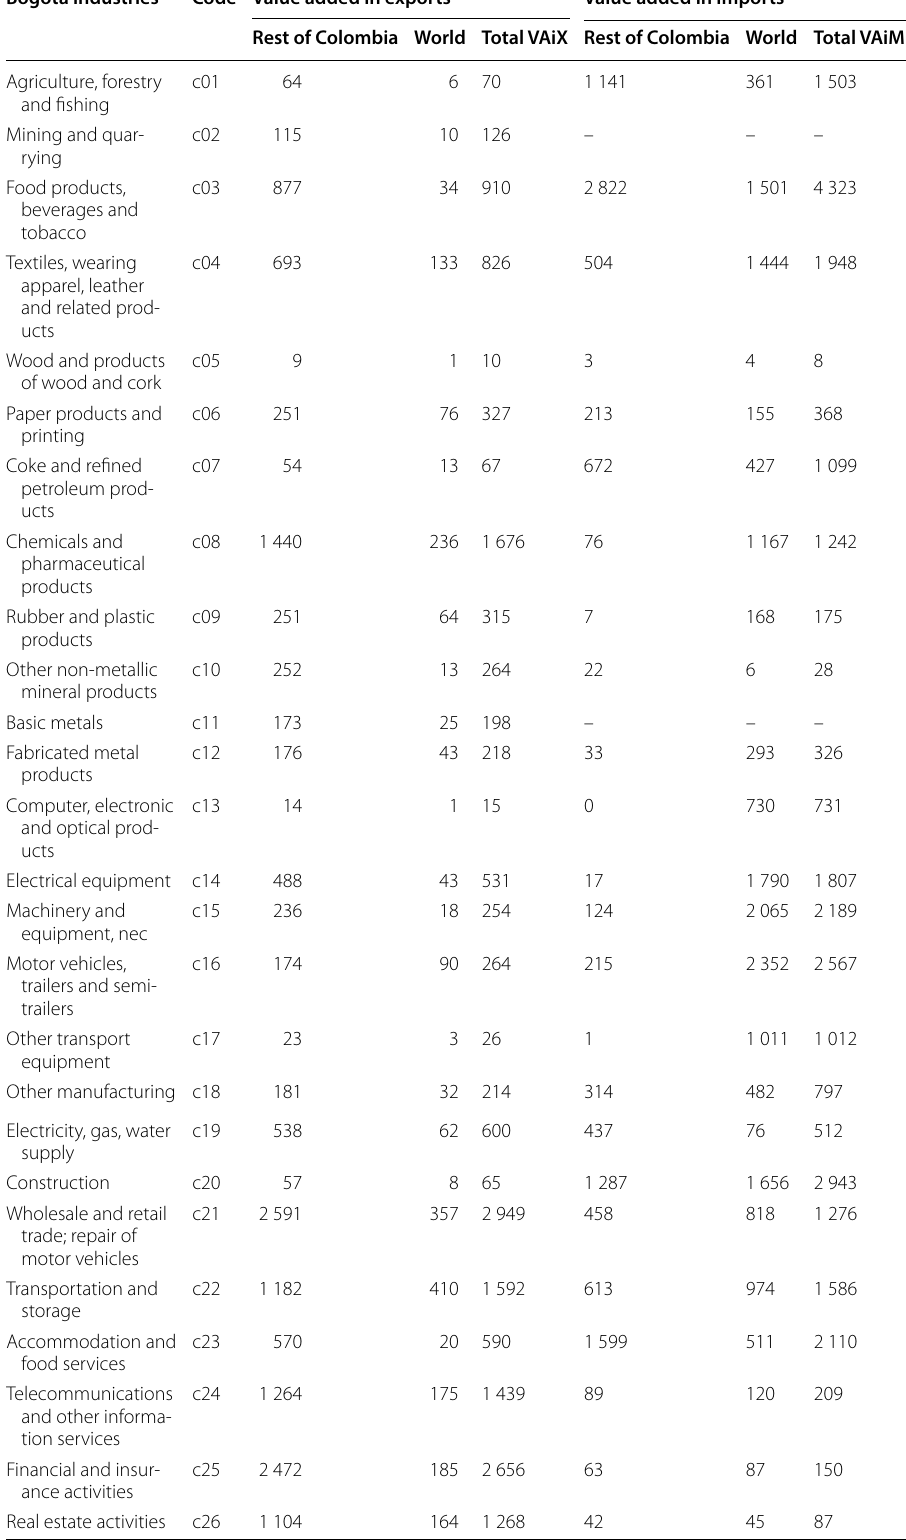
Table 6 Value added in exports and imports. Bogotá, millions of US dollars, 2012 Bogota industries Code Value added in exports Value added in imports Rest of Colombia World Total VAiX Rest of Colombia World Total VAiM Agriculture, forestry and